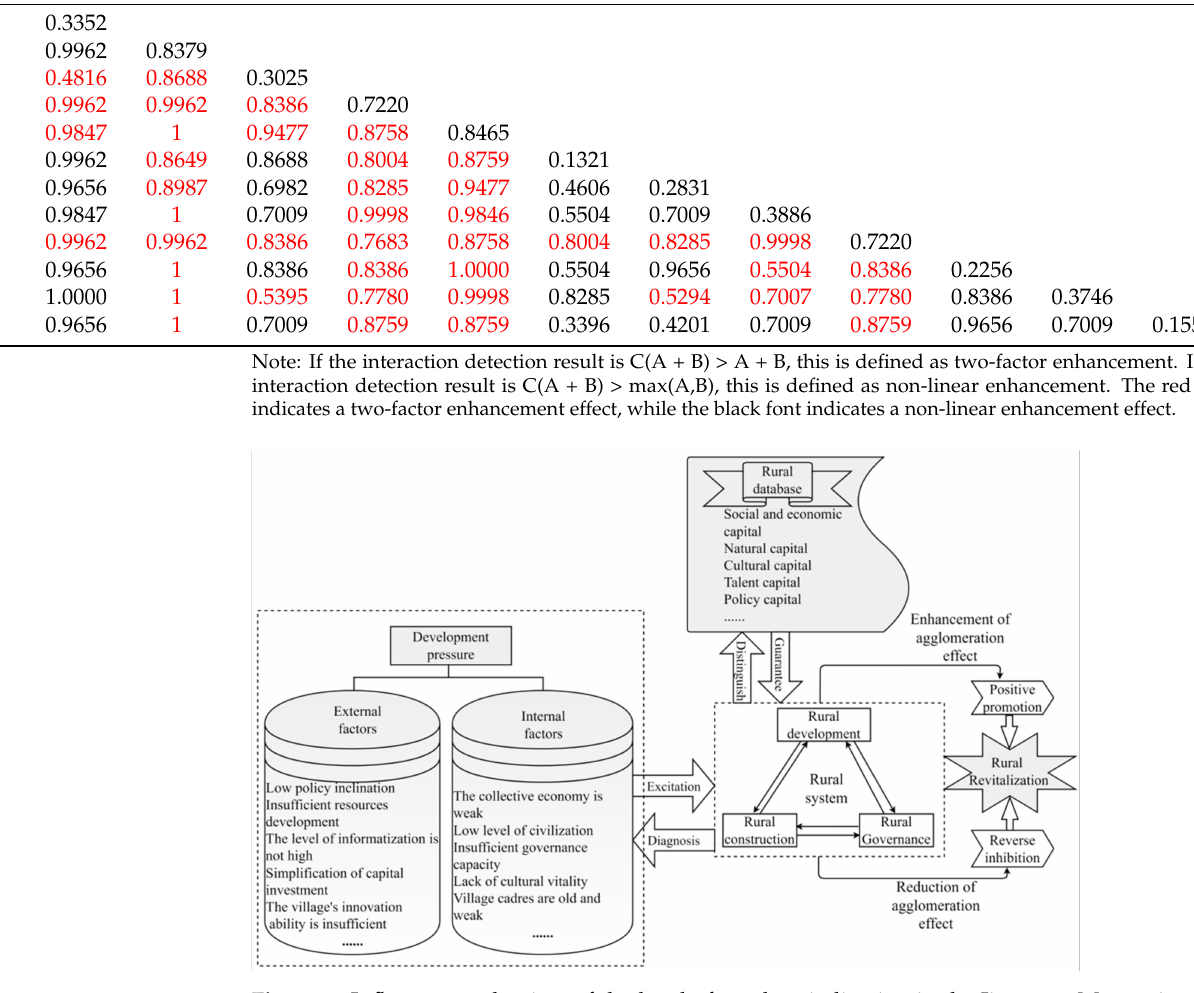
Figure 9. Influence mechanism of the level of rural revitalization in the Jinggang Mountain rural revitalization demonstration area, Jiangxi